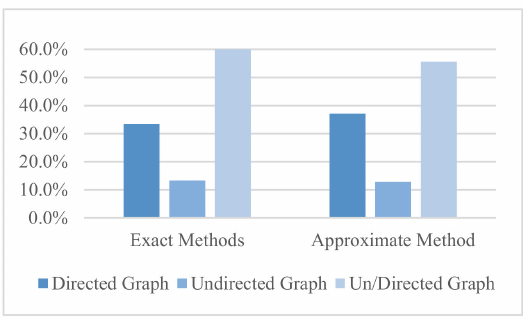
Figure 29. Overlap between Graph types and Method